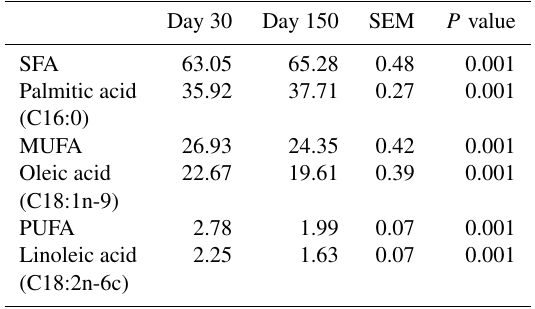
Table 3. Distribution of milk fatty acids (%) around days 30 and 150 of lactation in Holstein cows.